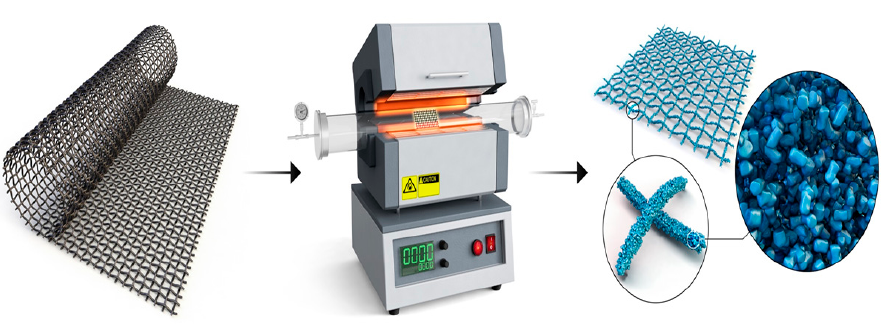
Figure 1. Schematic illustration of the MoO 3 − X electrodes and their synthesis process.